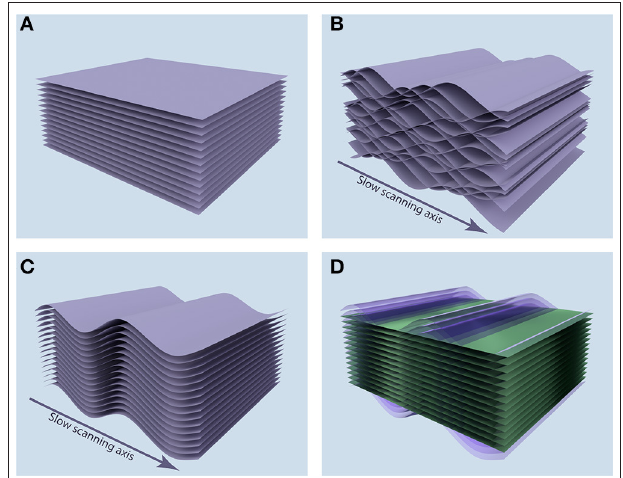
FIGURE 1 | Position of acquired image stacks in the tissue. (A) When the sample is static, the acquired images (purple sheets) correspond to the tomographic tissue sectioning by the optical plane. (B) When the sample is subjected to the periodic motion along the depth axis, acquired images correspond to complicated surfaces in the sample, leading to discontinuity in the 3-D volume of the acquired image stack. (C) Synchronization allows for the recovery of 3-D continuity, but the image stack corresponds to a distorted volume in the sample. (D) After measuring the periodic distortion profile, we can reconstruct the plane tomographic tissue sectioning (green planes) by resampling the acquired image data (purple